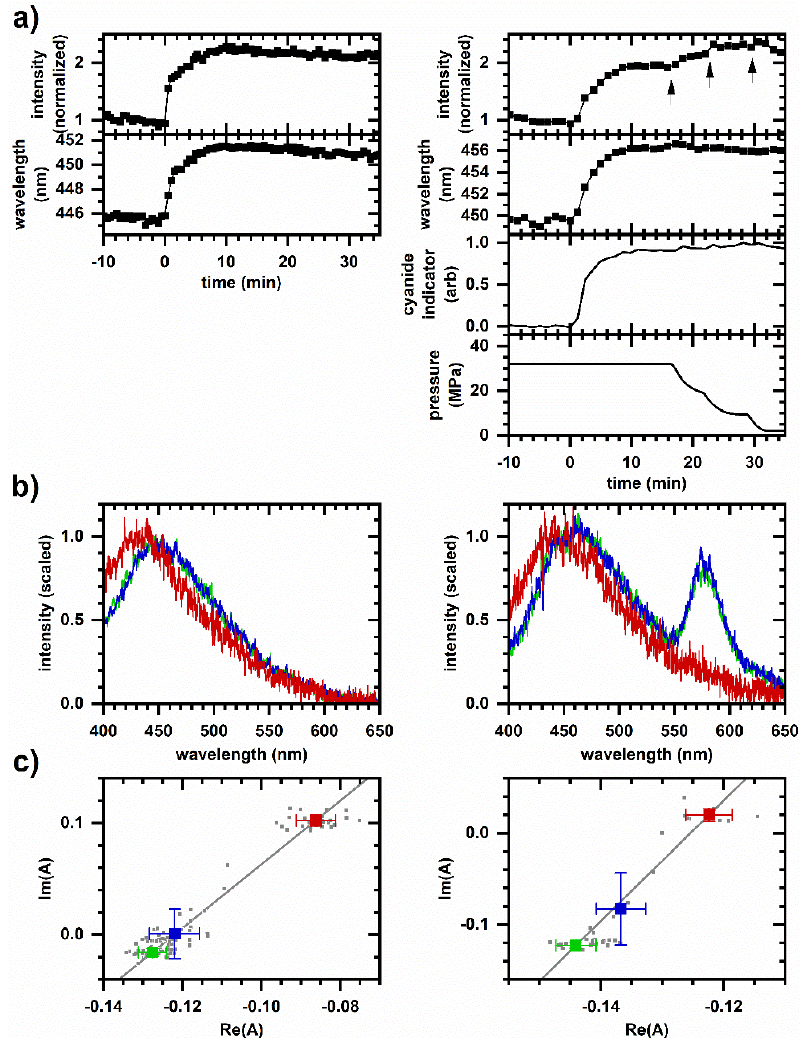
Figure 1. Cellular autofluorescence response to cyanide. Left column, 8 mM cyanide at ambient pressure in a spectroscopic cuvette. Right column, 25 mM cyanide at 32 MPa pressure in the microp- erfusion system. Representative responses are shown; behavior is reproduced on N independently prepared samples, N > 50 at ambient pressure and N = 4 at high pressure. ( a ) Autofluorescence inten- sity and average emission wavelength versus time. Spectrally integrated autofluorescence intensity is normalized to the intensity averaged over 10 min prior to cyanide introduction. Autofluorescence wavelength is plotted as an intensity-weighted average emission wavelength. Time is shifted so that cyanide is introduced to the sample at t = 0 min. For the microperfusion data, 1 µ M rhodamine is added to the reservoir as a cyanide indicator; shown is the integrated emission intensity for pixels 675–725 (572–585 nm wavelength) scaled to be between 0 and 1. The measured pressure is also shown. Arrows indicate intensity increases when pressure is released. ( b ) Representative emission spectra. Red—Prior to cyanide introduction; blue—10 min after cyanide introduction; green—20 min after cyanide introduction. Spectra are scaled to minimize the least-squares difference. For the mi- croperfusion data, the peak at 575 nm wavelength is due to the rhodamine indicator. ( c ) Phasor plots. Small symbols are phasors calculated from individual measurements. Large symbols are average and standard deviations of phasor values. Color corresponds to time intervals over which phasor values are averaged: red—10 min prior to cyanide introduction; blue—first 10 min after cyanide introduction; green—second 10 min after cyanide introduction. Gray line is a linear least-squares fit to the large symbols. Intensity, average emission wavelength, phasor, and least-square minimization are calculated from a measured spectrum using the first 400 pixels (400–500 nm